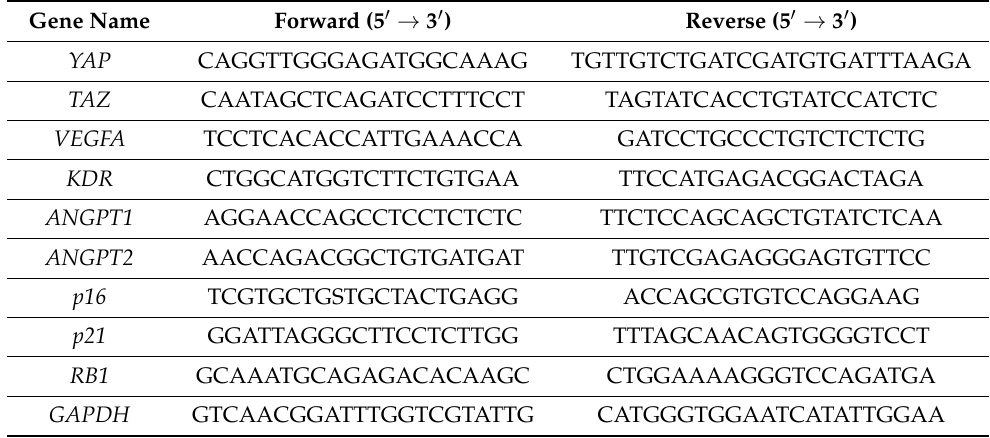
Table 1. Primer sequences used in